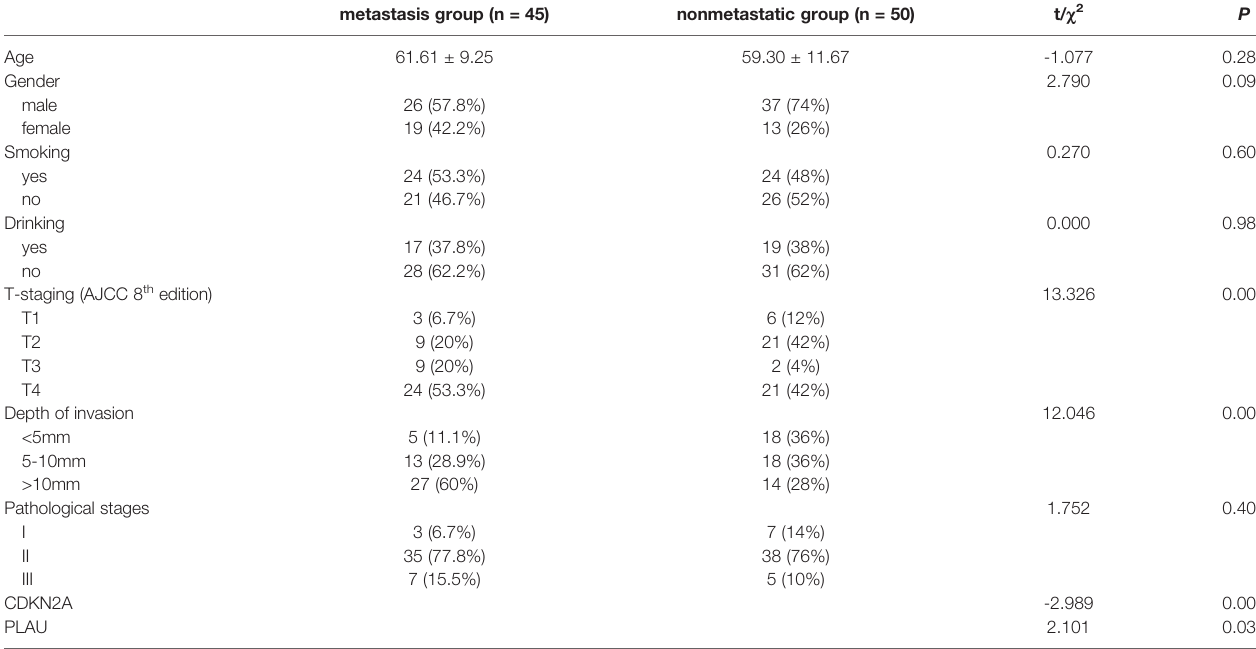
TABLE 2 | 95 OSCC clinicopathological parameters and gene expression analysis in prospective